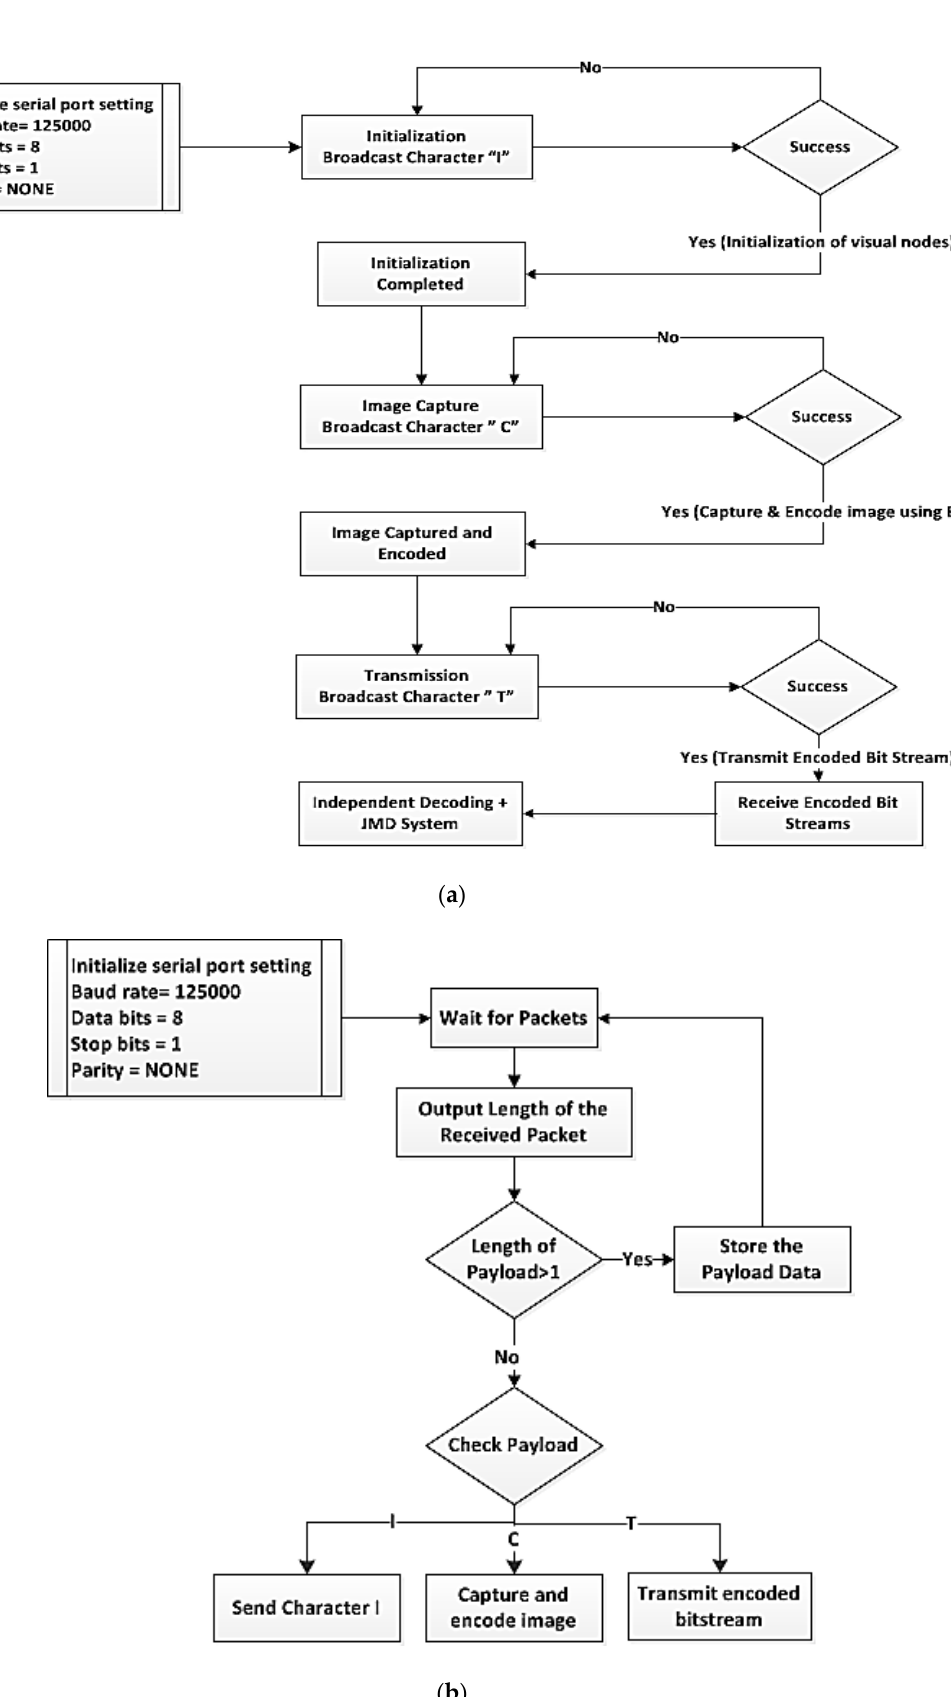
Figure 8. ( a ) Transmission process at the server (coordinator); ( b ) Transmission process at the visual node (end device).